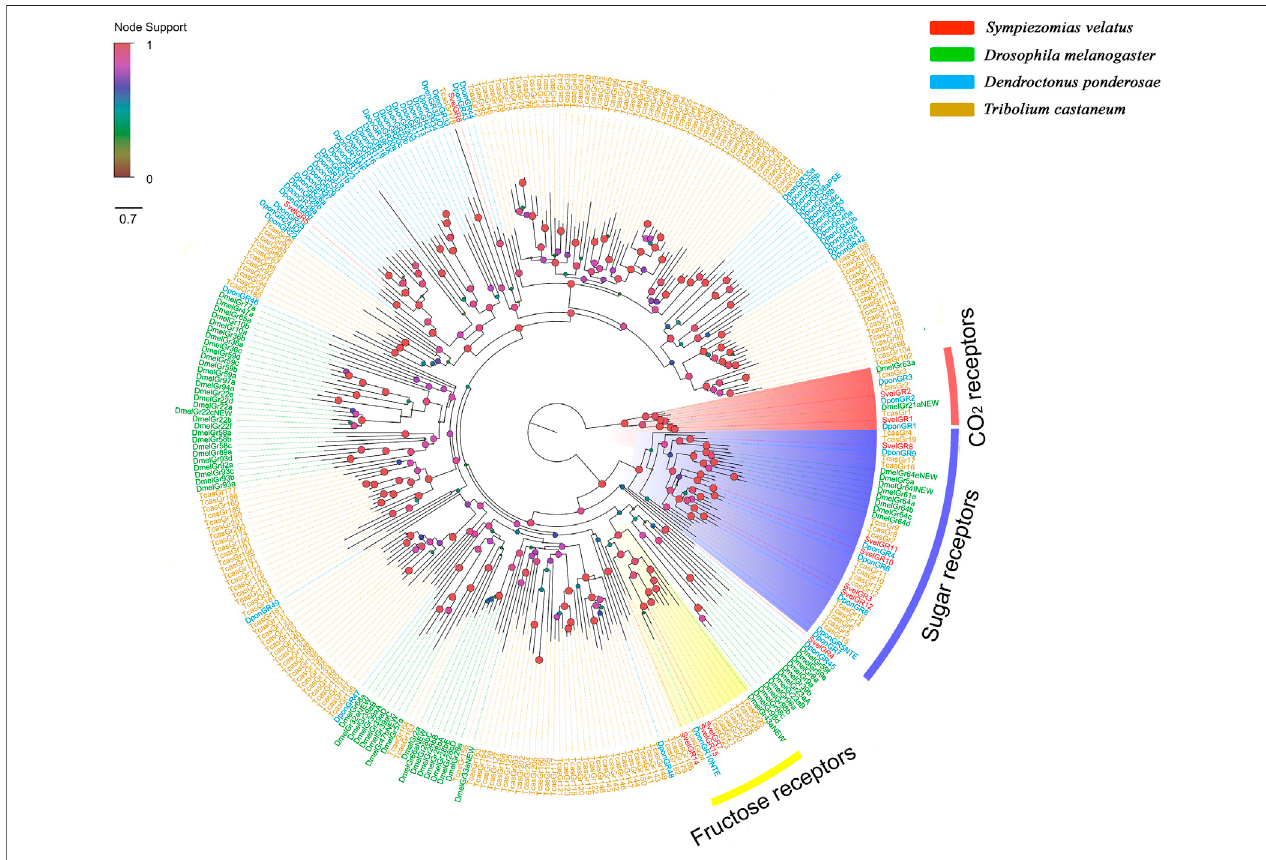
FIGURE 4 | Phylogenetic tree of the candidate gustatory receptors (GRs), rooted with the conserved lineage of putative CO 2 /sugar receptors. The GR sequences included were from Sympiezomias velatus (Svel, red), Dendroctonus ponderosae (Dpon, blue), Tribolium castaneum (Tcas, yellow) and Drosophilamelanogaster (Dmel, green). The tree was constructed using FastTree based on a MAFFT alignment. The local support values based on the Shimodaira-Hasegawa (SH) test are indicated by the colored circles and increase with the brightness and size of the circles.